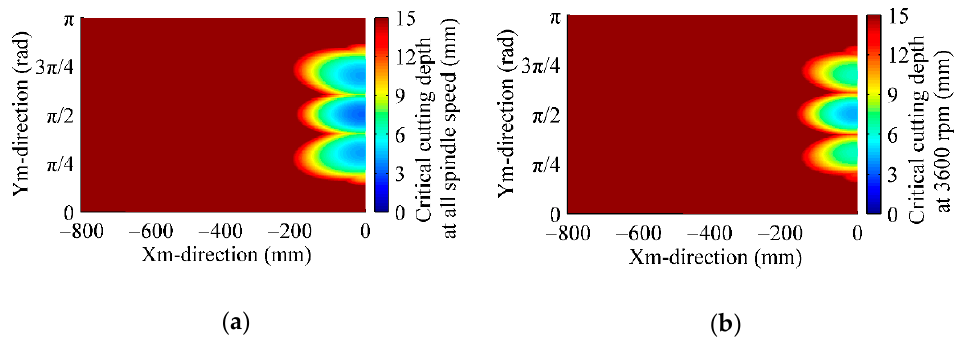
Figure 10. 3D stability lobe diagrams (SLDs) of the semi-conical workpiece considering the first three modes in the Z m -direction: ( a ) absolute critical cutting depth for each position of the workpiece at all spindle speed; ( b ) relative critical cutting depth for each position of the workpiece with the spindle speed at 3600 rpm.